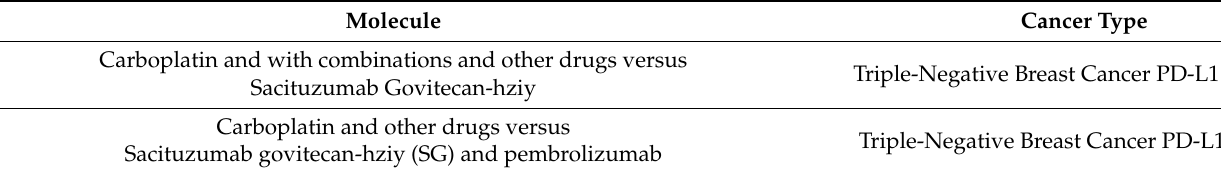
Table 3. Recent clinical trials on cisplatin